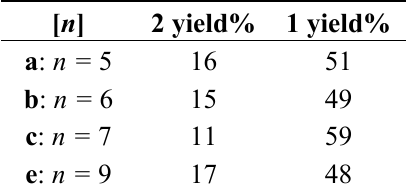
Table 5. The Swern oxidation of compound 3 to obtain products 2 and 1